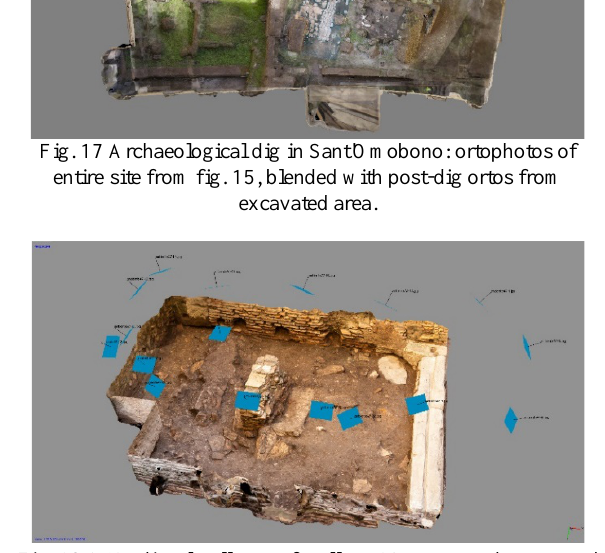
Fig. 18 A Medieval collapse of walls, a 12 mq area, documented with Photoscan for digital preservation and digital relief.